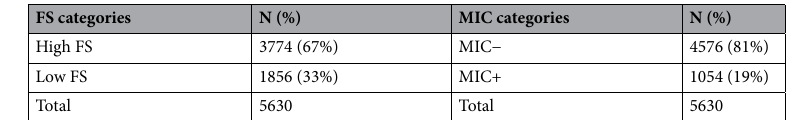
Table 2. Distribution of functional status (FS) categories and MIC in the study population. Proportions (%) calculated with the total (N = 5630) as the denominator. Low FS defined as the sum of scores from the self-reported limitations in the Katz Index of Independence in Activities of Daily Living (range 0–5) and the Lawton-Brody Instrumental Activities of Daily Living Scale (range 0–8) less than 11. MIC, malnutrition- inflammation-complex; FS, functional status.